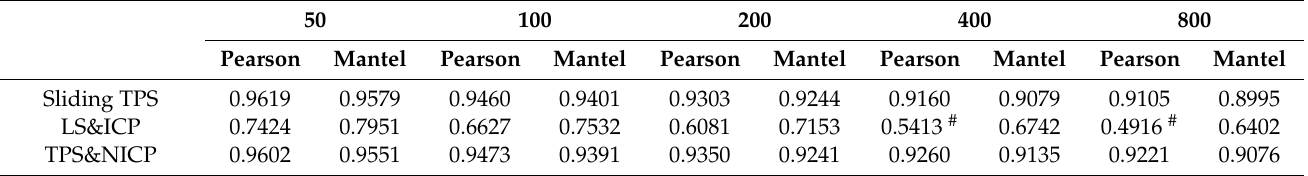
Table 6. Pearson and Mantel correlations (all p < 0.01, except # , p < 0.05) between vectors and matrices of Procrustes distances from each semilandmarking approach and density and those from the landmarks alone.